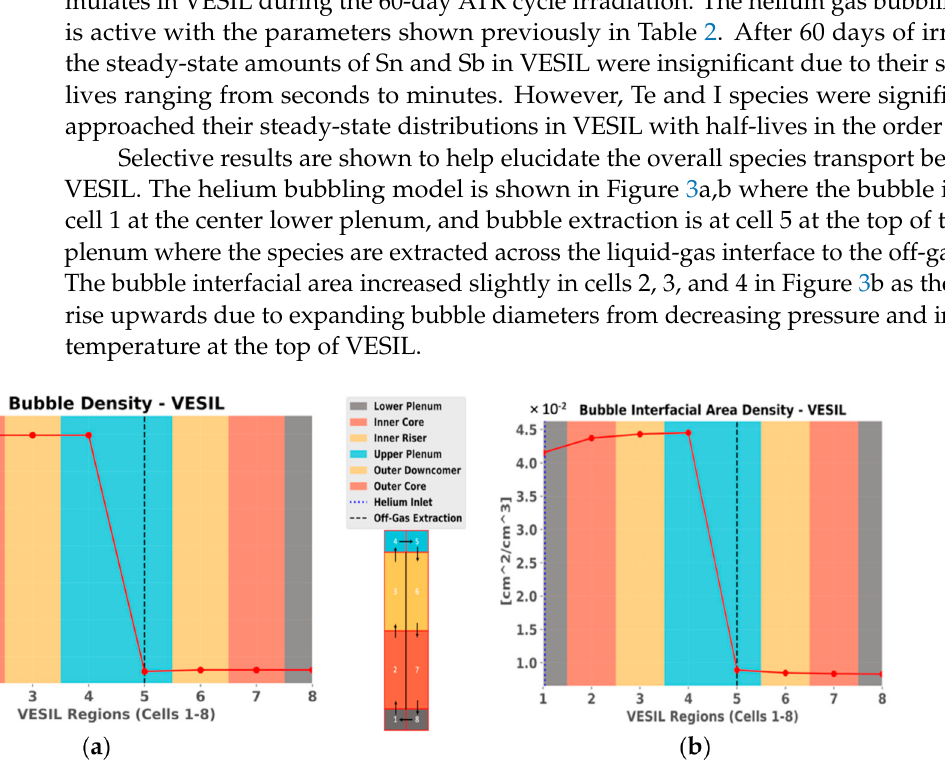
Figure 3. ( a ) Bubble density (#/cm 3 ); ( b ) Bubble interfacial area density (cm 2 /cm 3 or cm − 1